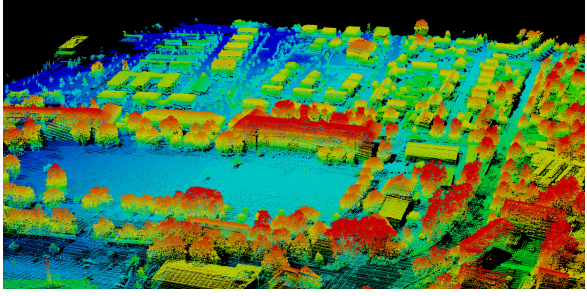
Figure 4. ALS data of the test